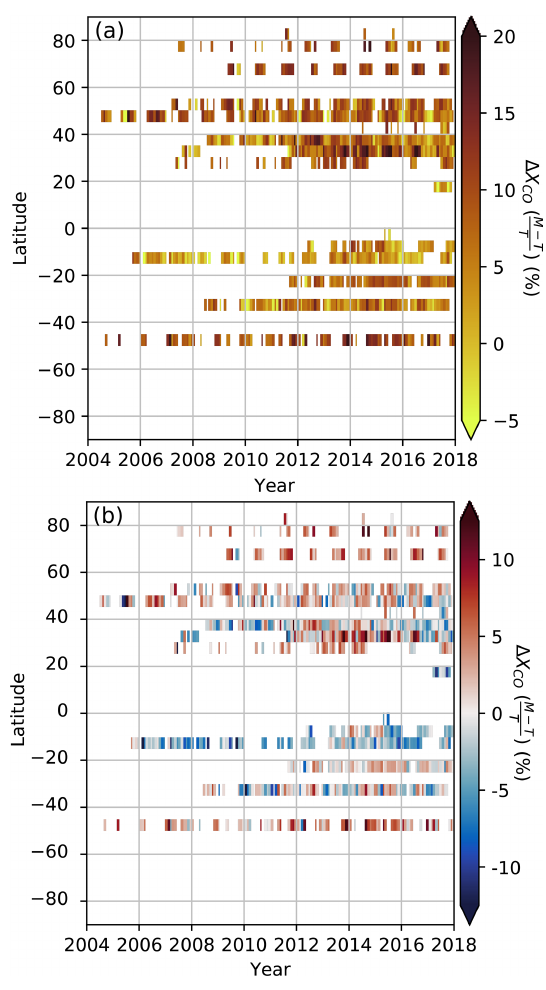
Figure 7. Rotated Hovmöller diagram of the mean percent differ- ences between binned MOPITT and TCCON data using method II (Sect. S6.1). Latitude bins are 5 ◦ zonal bands, and temporal bins are monthly; (a) uses standard TCCON data, and (b) is without the TCCON scaling to aircraft (WMO scale – see Sect.